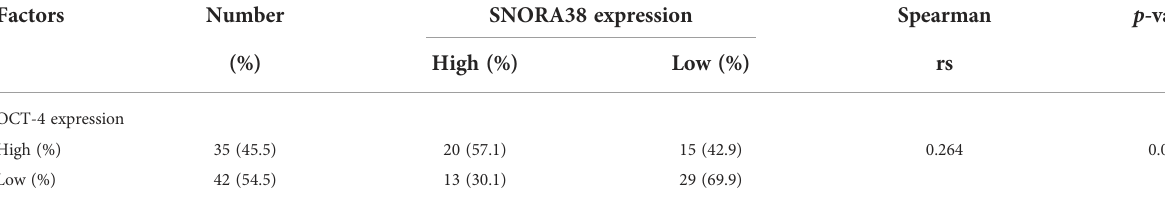
TABLE 4 Correlation analysis of SNORA38 expression and OCT-4.